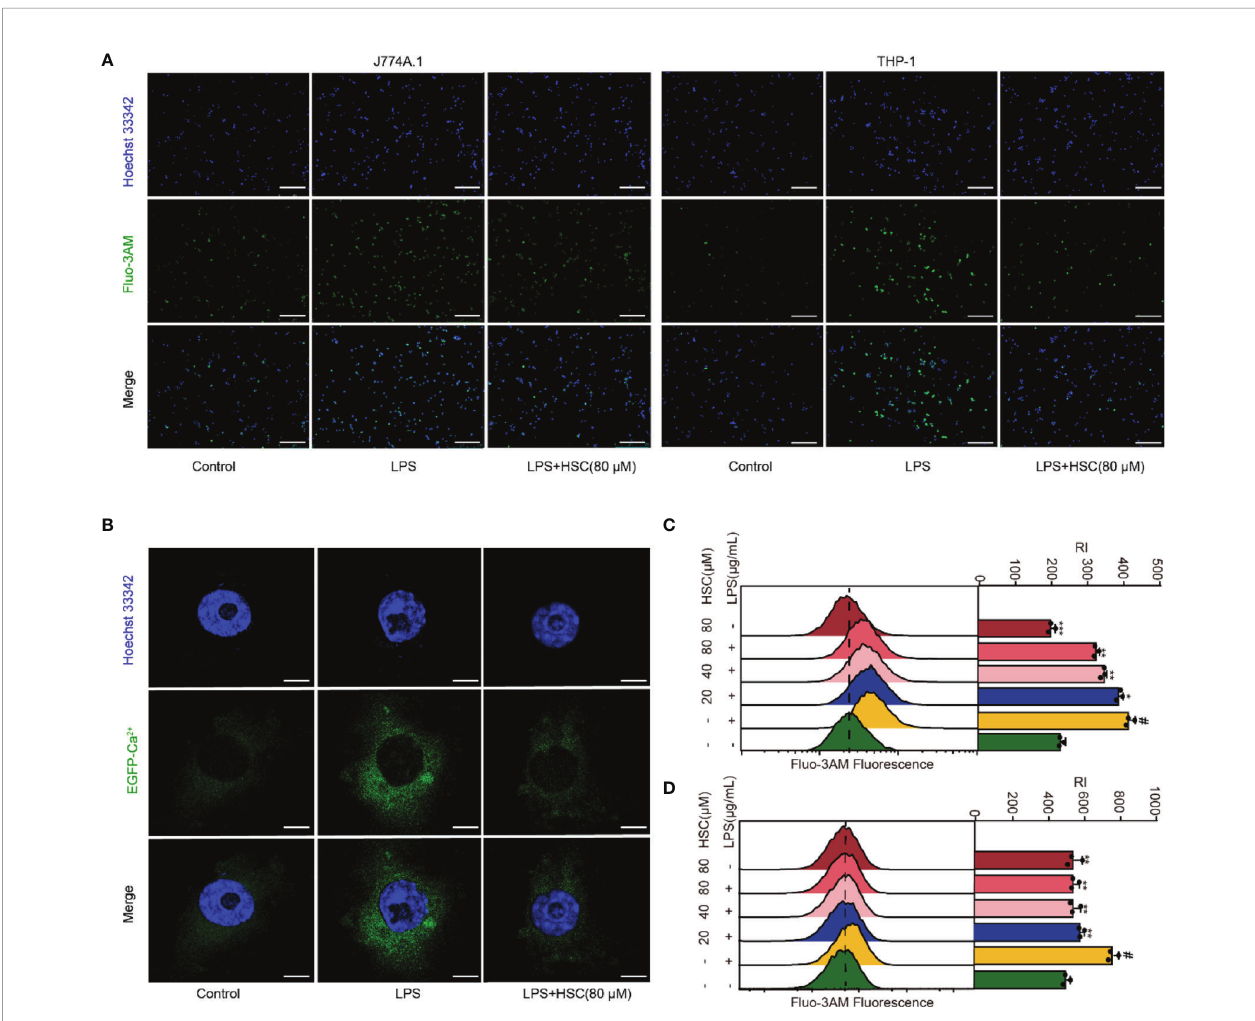
FIGURE 4 | Effect of HSC on Ca 2+ release in macrophages. RAW264.7, J774A.1, THP-1 cells were treated with HSC for 4 h and incubated with LPS for 6 h; (A) J774A.1 and THP-1 cells were stained with Fluo-3/AM (10 m M) for 1 h. The images were captured by fl uorescence microscopy (Scale bar=10 m m); (B) Plasmid of EGFP-Ca 2+ was transfected in J774A.1 cells for 48 h, Ca 2+ fl uorescence was determined by immuno fl uorescence (Scale bar=20 m m); (C, D) RAW264.7 and THP-1 cells were stained with Fluo-3/AM for 1 h, and the fl uorescence intensity was assessed by fl ow cytometry; # P < 0.001 compared to control alone group; * P < 0.05, ** P < 0.01, and *** P <0 .001, versus the LPS group,